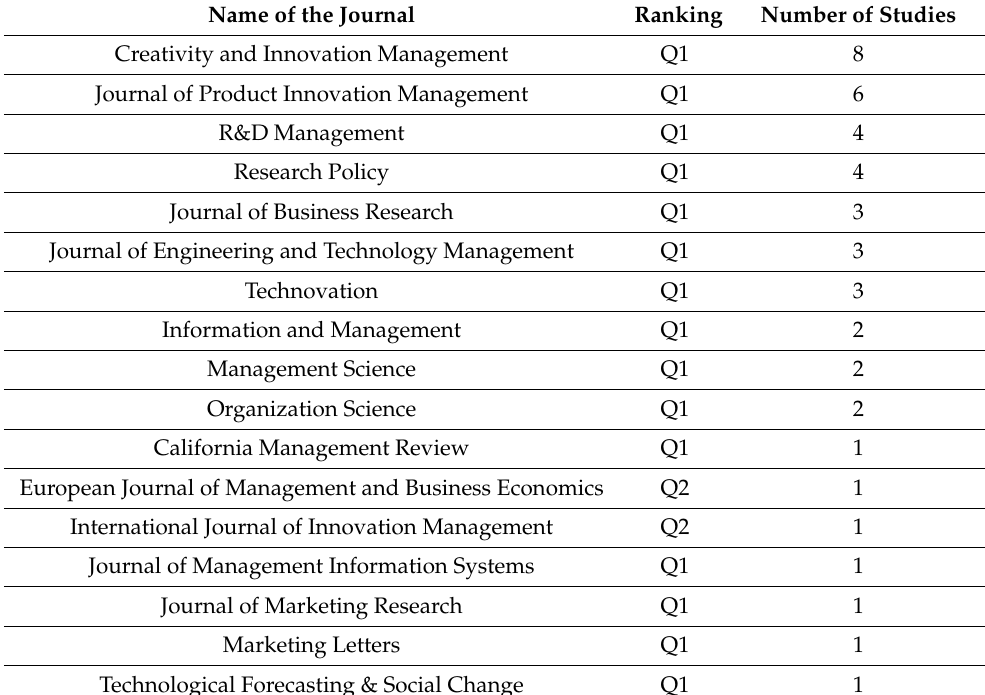
Table 6. The name and ranking of the journals and the number of studies retrieved.